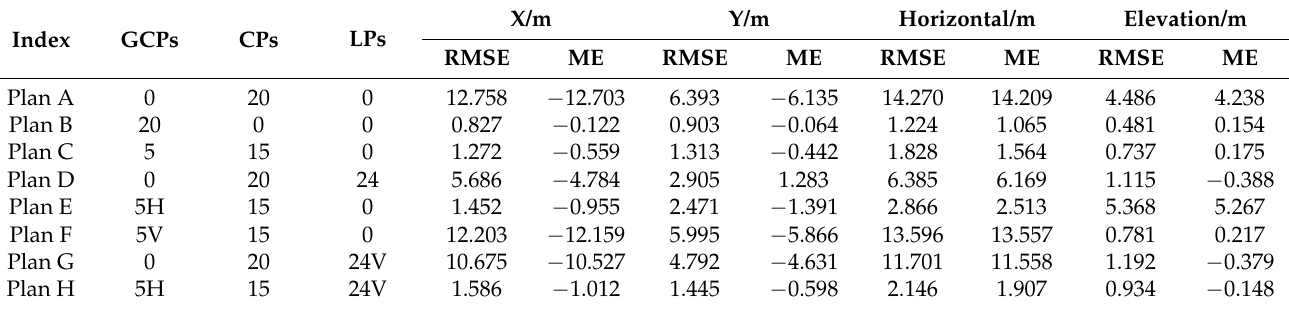
Table 2. Experimental results in the Shaanxi area.